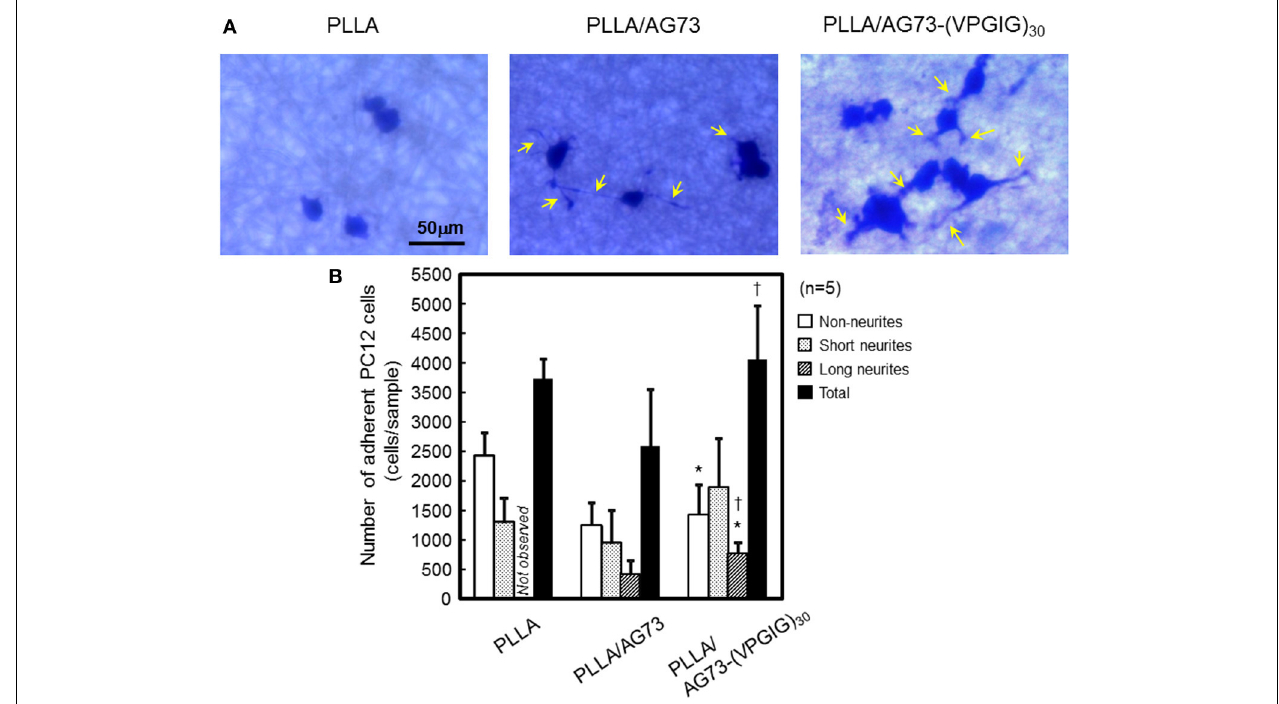
FIGURE 3 | Adhesion and neurite outgrowth of NGF-treated PC12 cells on electrospun nanofibers. (A) Morphology of NGF-treated PC12 cells 48h after seeding. Yellow arrows indicate neurites. (B) The number of adherent